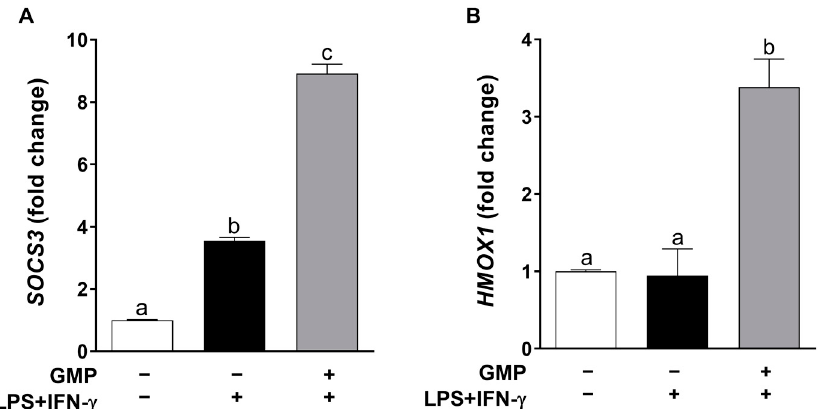
Figure 6. Effect of pretreatment with GMP on macrophage expression level of regulatory molecules. Expression levels of ( A ) SOCS3 and ( B ) HMOX1 were represented relative to GAPDH , analyzed by quantitative PCR, and expressed as fold change. ( n = 3 independent experiments). Means followed by different letters (a, b, c) are significantly